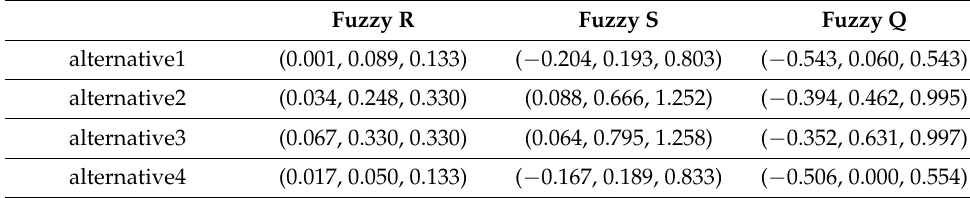
Table 6. The fuzzy values S, R, and